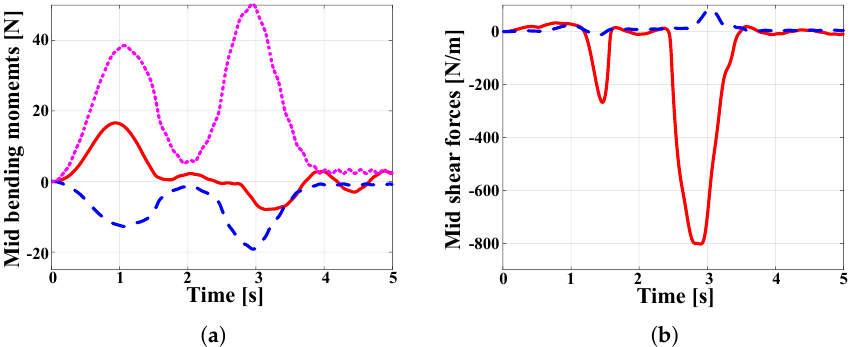
Figure 13. Stress resultants at the center point of the half cylinder. ( a ) Bending moments: M 11 (dotted line), M 22 (dashed line), and M 12 (solid line). ( b ) Transverse shear forces: Q 1 (solid line), and Q 2 (line